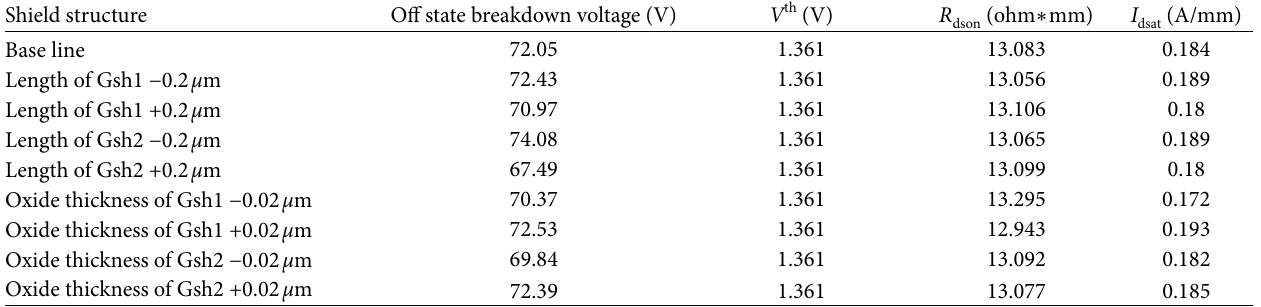
Table 1: DC data from simulation.